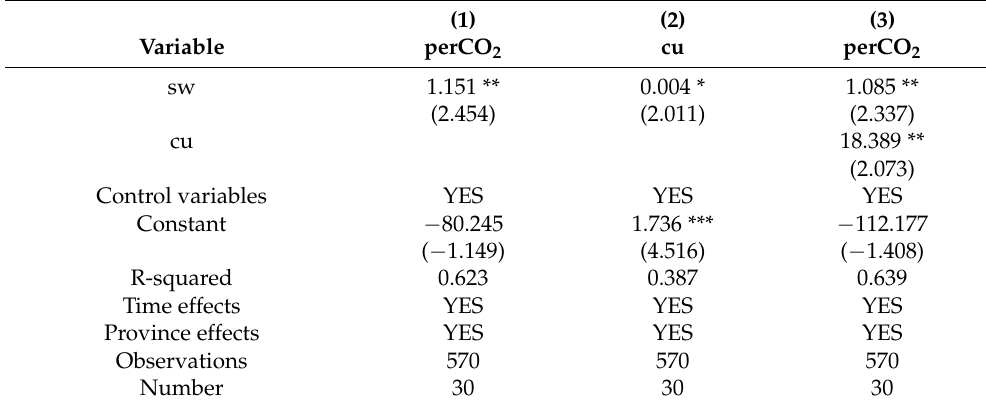
Table 4. Robustness results.